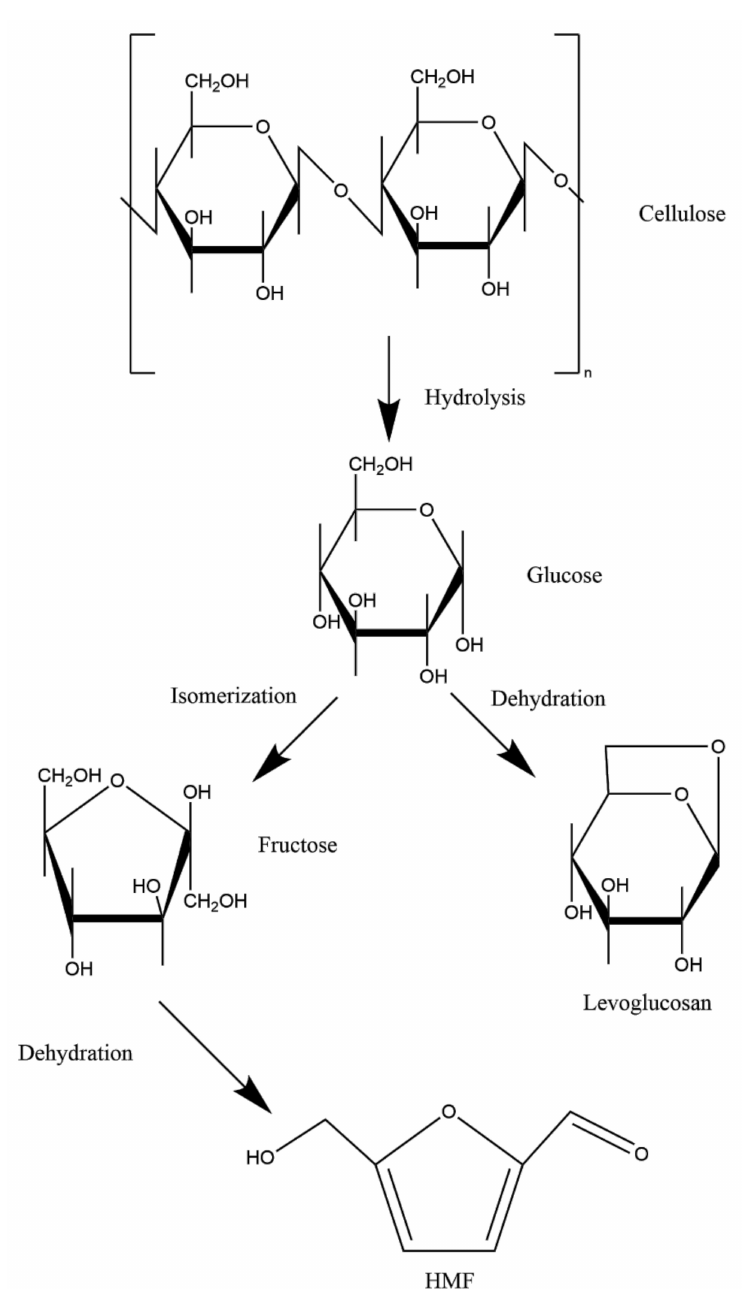
Figure 2. Mechanism of tobacco cellulose degradation under influence of high temperature and formation of HMF and levoglucosan (based on literature